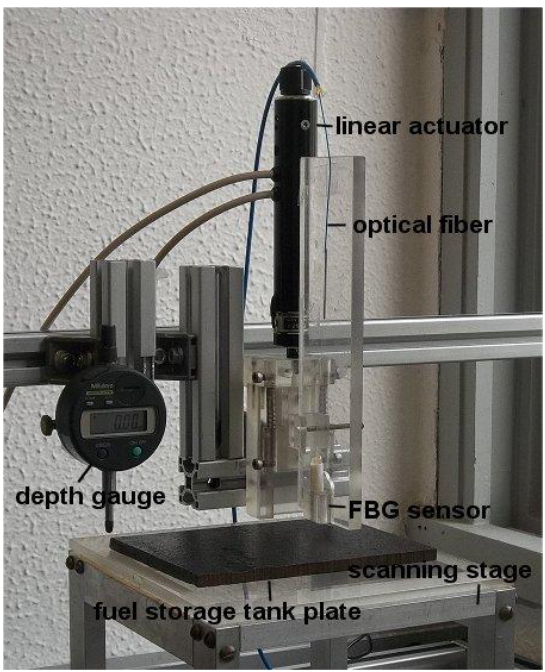
Figure 7. XYZ-motorized stage used to scan steel plates with fabricated semi-spherical and natural corrosion pits under the depth gauge and FBG force sensors.